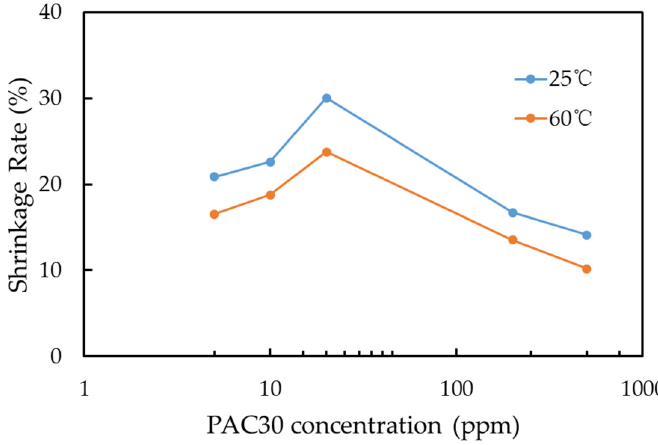
Figure 6. Curve of expansion rate of PAC30 with temperature and concentration.